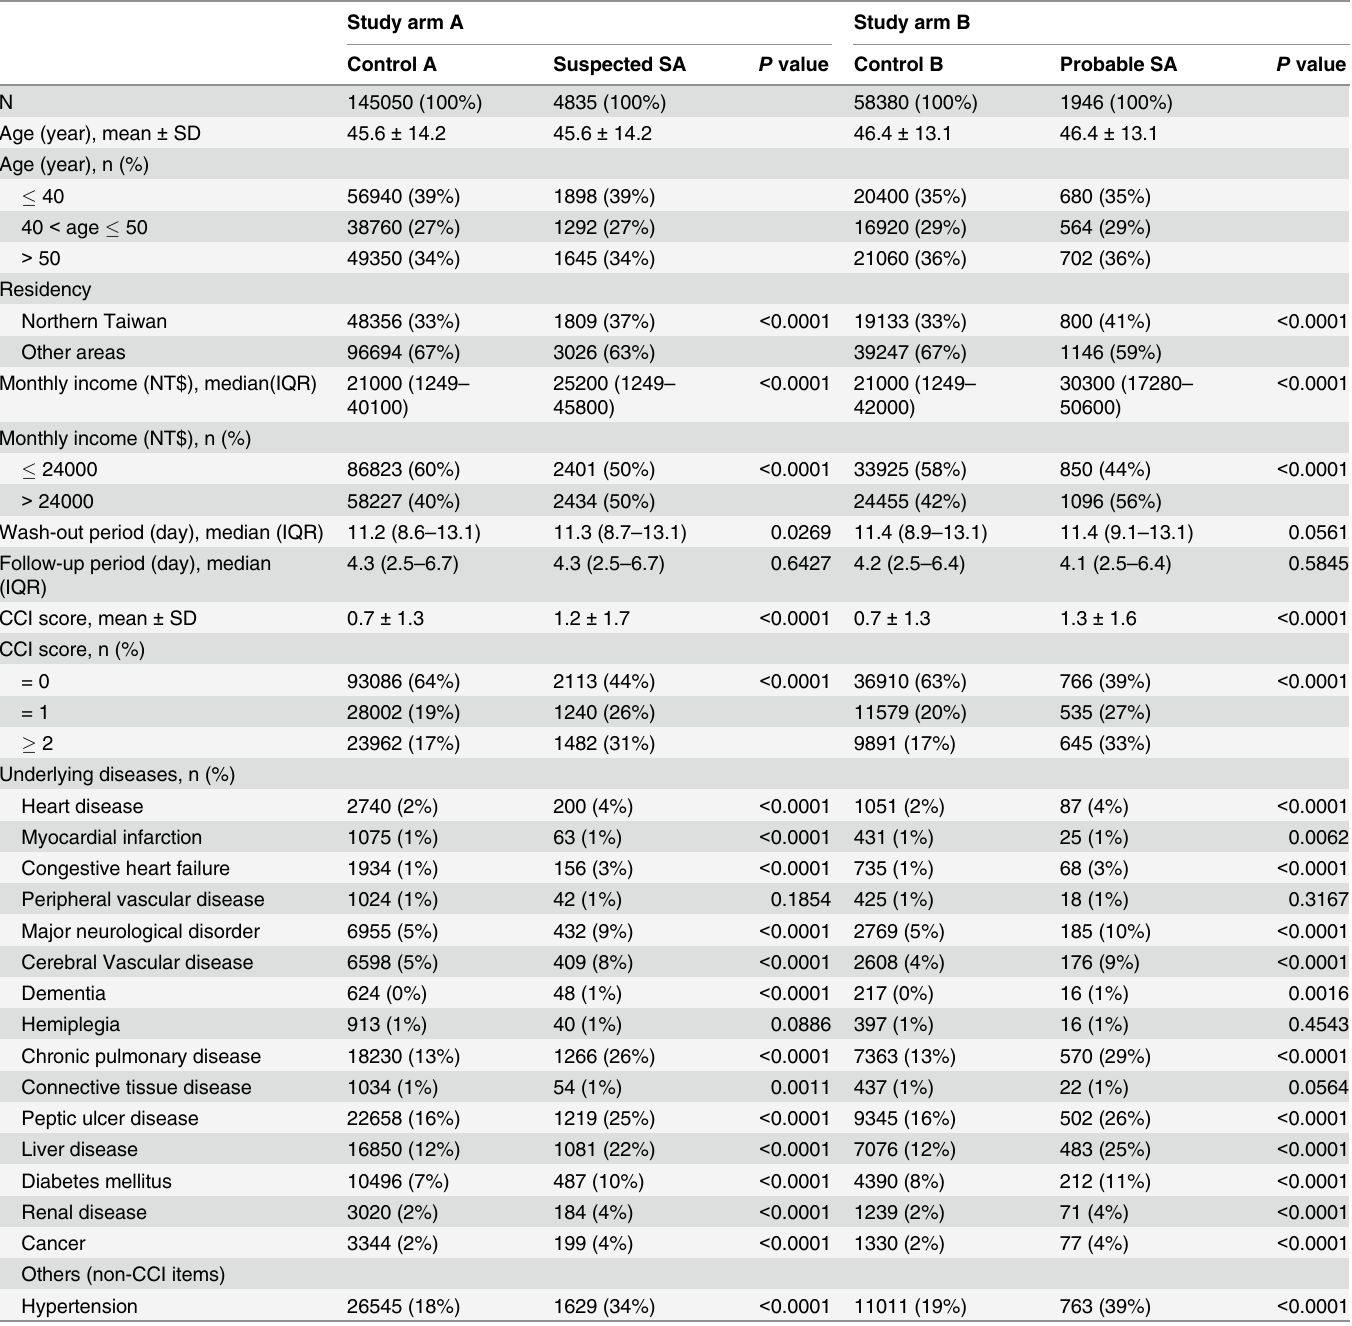
Table 1. Baseline characteristics of the study